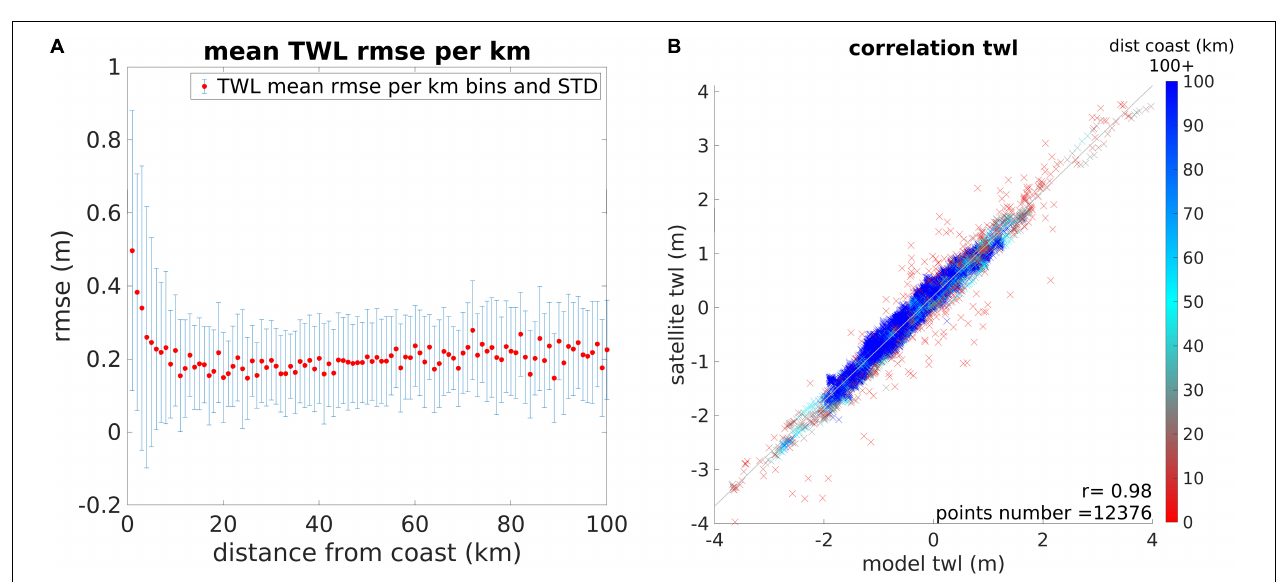
FIGURE 9 | Statistics for the Amm15-C2 comparison. Mean monthly results from June 2016 to September 2017 (for Amm15-C2).